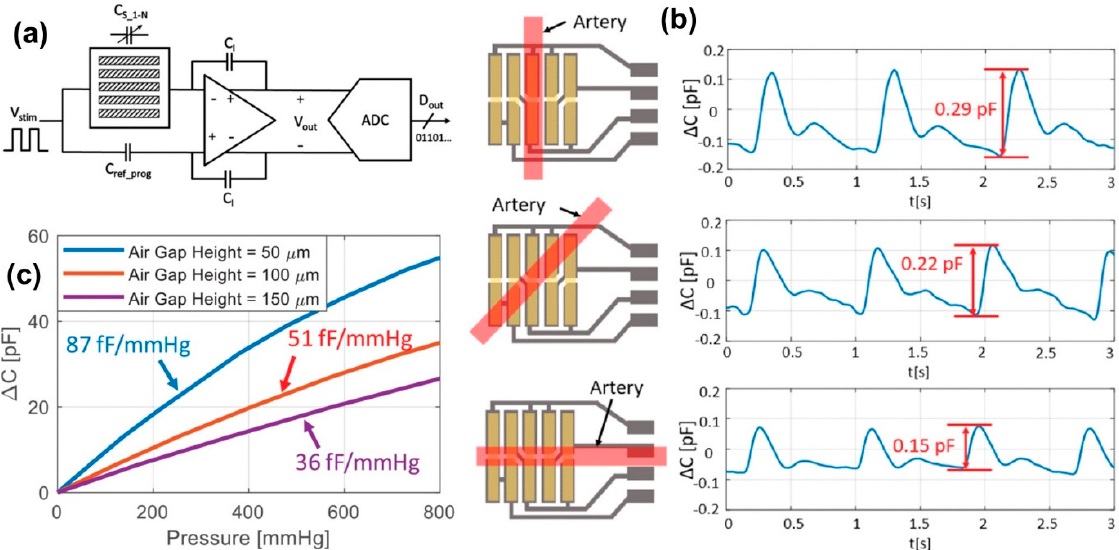
Figure 16. ( a ) Sensor array with CMOS interface circuitry. ( b ) Measured blood pressure pulse waveform under different orientations at the ankle. ( c ) Simulated sensitivity with different airgap sizes. Reprinted/adapted with permission from Ref. [163]. Copyright 2020, IEEE. Table 8. A summary of fabric integrated tactile sensors, materials and typical performance data discussed and reviewed by Castano et al.